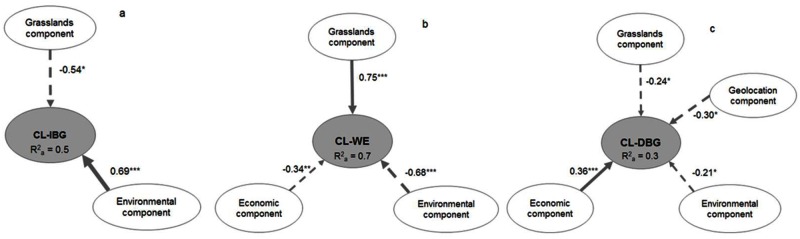
Final structural equation models for the relationships between the agropastoral system component and connectivity loss caused by a) increases in biomass and greenness (CL-IBG), b) woody encroachment (CL-WE), and c) decreases in biomass and greenness (CL-DBG).Arrow thickness reflects the contribution from the exogenous latent variables (agropastoral system components) to the endogenous latent variable (connectivity loss). The numbers on the lines denote the standardized regression coefficients (β), and the statistical significance is indicated as follows: * p ≤ 0.05, ** p ≤ 0.01 and *** p ≤ 0.001. R2a represents the adjusted R2 of the endogenous variable.